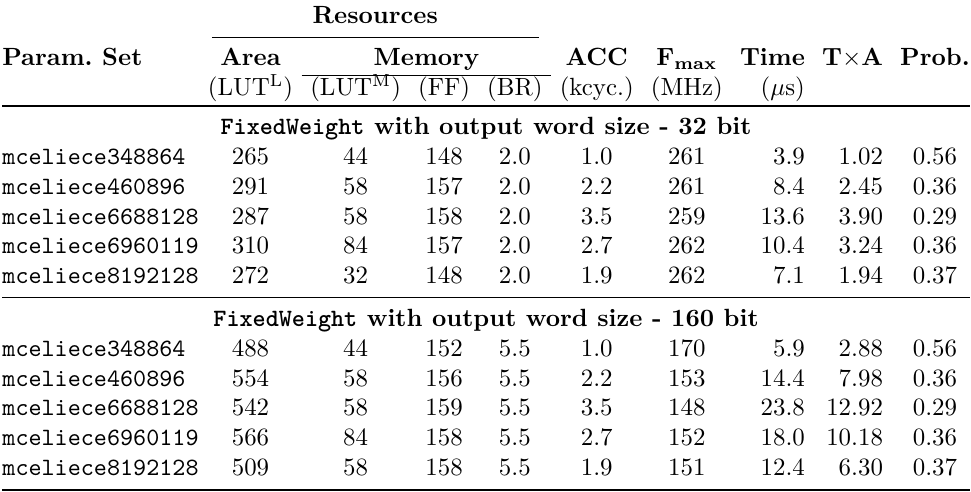
Table 7: Comparison of the time and area for our FixedWeight hardware module with output word sizes 32-bits and 160-bits targeting Xilinx Artix 7 ( xc7a200t ) FPGA. Resources Param.